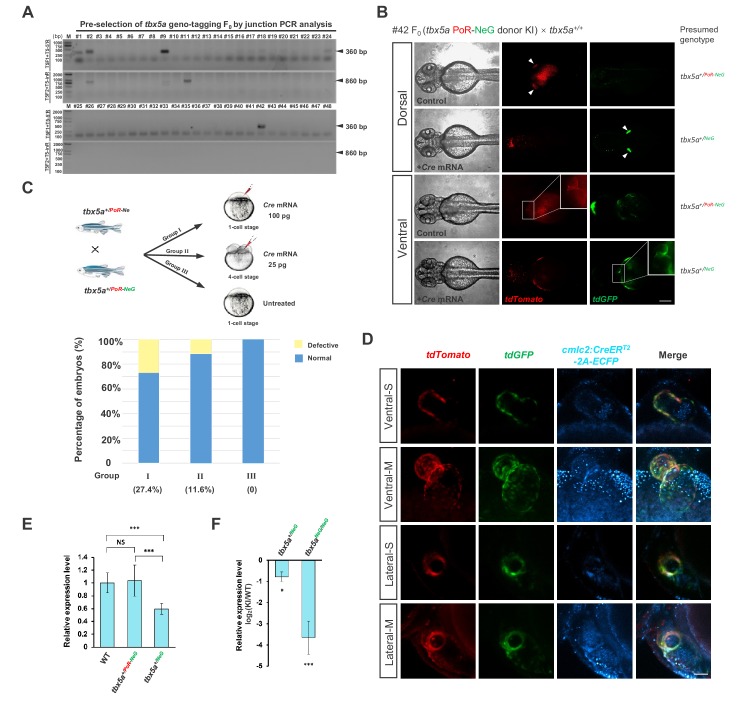
Evaluation of the tbx5a geno-tagging effect.(A) Preselection of tbx5a geno-tagging F0 individual by junction PCR analysis. 5’ or 3’ junctions were amplified by PCR using genomic DNA extracted from fin clips of the #1, #2, #9, #11, #24 and #42 F0 adult fish. The corresponding primer pairs are shown on the left side of the gel images, and the positions of these primers can be found in Figure 3A. (B) Switching of fluorescent signals achieved from the tbx5a geno-tagging allele after Cre mRNA injection into the F1 progeny from #42 positive F0 outcrossed with a wild-type zebrafish. The arrowheads indicate pectoral fins. The outlined boxed areas indicate the heart region, showing the change in the fluorescent signals in the heart before and after Cre mRNA injection. Scale bar, 200 μm. (C) The experimental design for the functionality test of the tbx5a geno-tagging allele. The progeny from the cross of a tbx5a+/PoR-NeG heterozygote with a tbx5a+/PoR-Ne heterozygote were divided into three groups: Group I was injected with 100 pg Cre mRNA at the one-cell stage, Group II was injected with 25 pg Cre mRNA in a single cell at the 4 cell stage, and Group III remained untreated as a control. The histogram shows the ratio of defective embryos after Cre mRNA injection in different groups. (D) Confocal images of the heart regions of two embryos from the cross of Tg(cmlc2:zCreERT2-2A-ECFP) transgenic fish with tbx5a PoR-NeG/PoR-NeG after 4-HT treatment, showing a red to green change in the fluorescent signals upon Cre induction. -S: Single-plane view, -M: Maximum intensity projection view of z-stack images. Scale bar, 50 μm. (E) qRT-PCR results showing the transcription level of the tbx5a locus in wild-type (WT) and tbx5a PoR-NeG geno-tagging donor KI zebrafish embryos at 72 hpf, using T5qF and T5qR primers. The tbx5a+/NeG and tbx5a+/PoR-NeG embryos were obtained from crosses of tbx5aPoR-NeG/PoR-NeG homozygotes with wild-type zebrafish with or without the injection of Cre mRNA, respectively. The average expression level of wild-type embryos was set as 1. (F) qRT-PCR results using T5qF and T5qR primers, showing the transcription level of the tbx5a locus in the tbx5a+/NeG and tbx5aNeG/NeG embryos derived from the Cre mRNA-injected tbx5a+/PoR-NeG and tbx5aPoR-NeG/PoR-NeG embryos, respectively. The original embryos were obtained from the crossing of tbx5aPoR-NeG/PoR-NeG homozygotes with tbx5a+/PoR-NeG heterozygote zebrafish. The expression levels in the KI embryos were normalized to the WT ones. Data are presented as the mean ±s.d., and a two-tailed Student’s t-test was applied to calculate p values in all the experiments. *: p<0.05. ***: p<0.001. NS: Not significant.